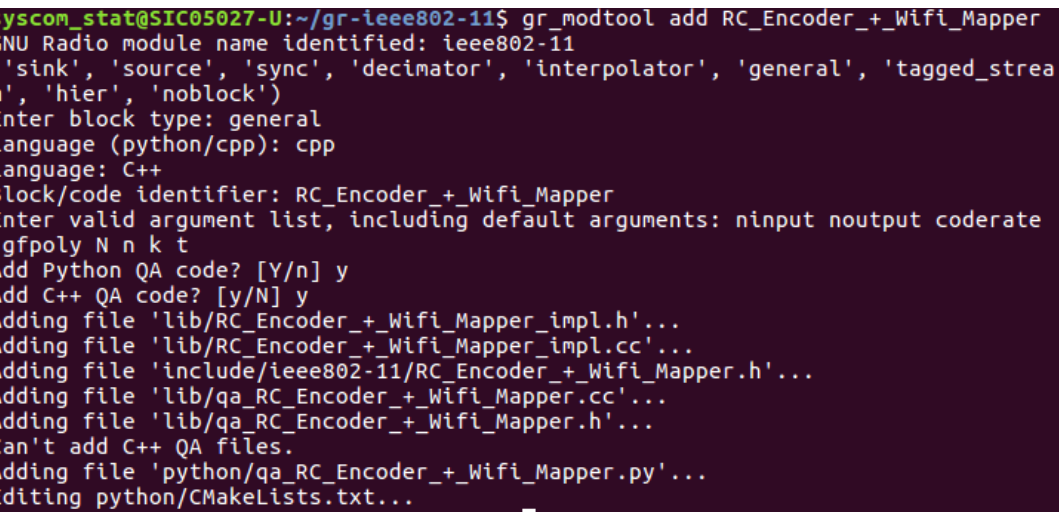
Figure 2. RC Encoder + WiFi Mapper block adding in gr-ieee